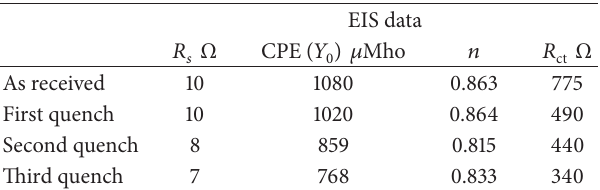
Table 5: Electrochemical impedance parameters of microalloy steel samples in 3.5% NaCl at room